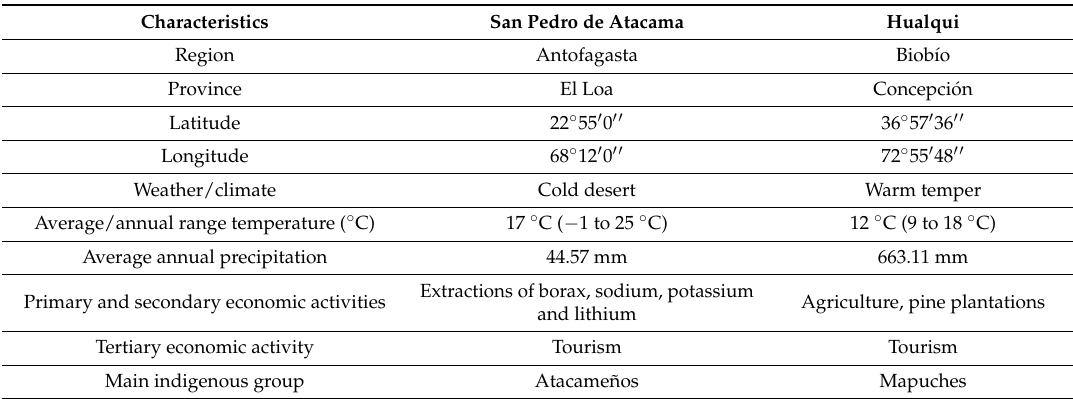
Table 1. Characterization of geography study areas: San Pedro de Atacama and